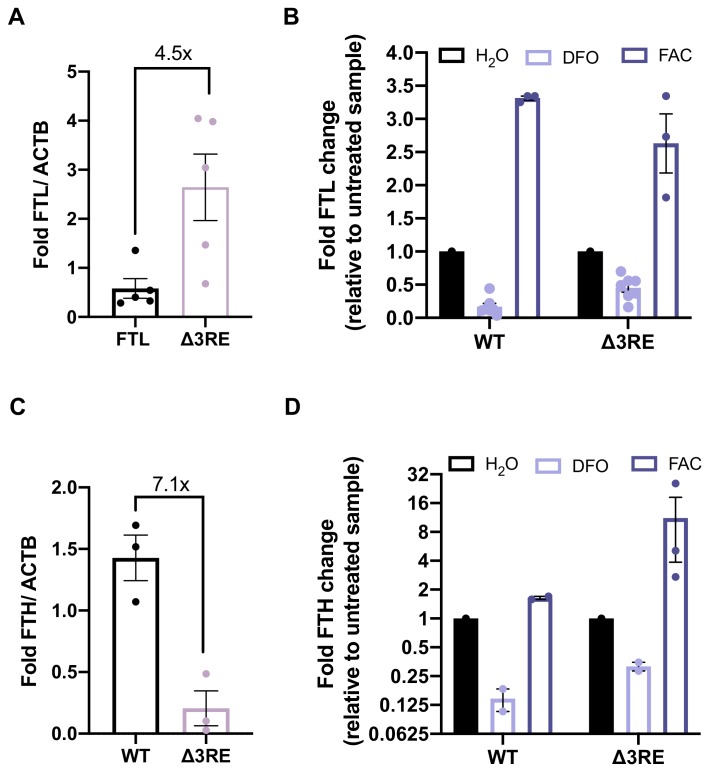
Quantification of FTL and FTH protein levels in HepG2 cells.(A) Quantification of western blots comparing the levels of FTL in wild type vs ∆3RE HepG2 cells. Five biological replicates are represented with error bars representing standard error of the mean. (B) Quantification of western blots comparing the levels of FTL in wild type vs ∆3RE HepG2 cells under various iron conditions. Iron donor treatment with 50 µg/mL FAC for 24 hr or iron chelation treatment with 200 µM DFO at for 24 hr. Three biological replicates are represented for FAC treatment and six biological replicates are represented for DFO treatment. Error bars represent standard error of the mean. (C) Quantification of western blots comparing the levels of FTH in wild type vs ∆3RE HepG2 cells. Three biological replicates are represented with error bars representing standard error of the mean. (D) Quantification of western blots comparing the levels of FTH in wild type vs ∆3RE HepG2 cells under various iron conditions. Iron donor treatment with 50 µg/mL FAC for 24 hr or iron chelation treatment with 200 µM DFO for 24 hr.10.7554/eLife.48193.018Figure 3—figure supplement 4—source data 1.Western blot quantification of FTL and FTH in HepG2 cells.